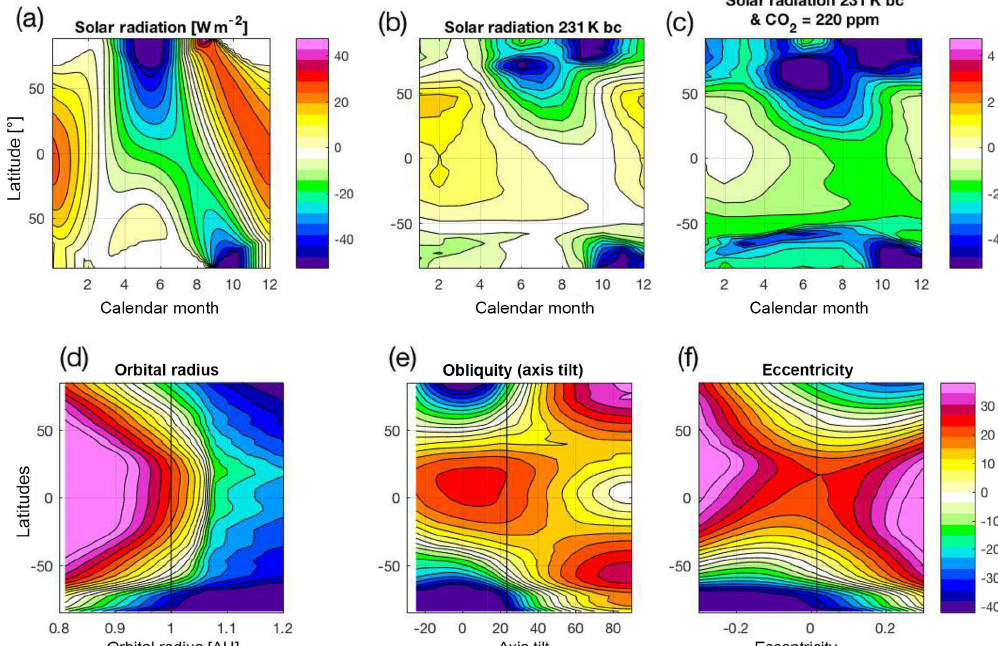
Figure 14. Orbital parameter forcings and T surf responses: (a) incoming solar radiation changes in the solar 231kyr experiment relative to the control GREB model. T surf response in solar 231kyr (b) and solar 231kyr 200ppm (c) relative to the control GREB model. Annual mean T surf in orbit radius (d) , obliquity (e) , and eccentricity (f) . The solid vertical line in (d–f) marks the control (today) GREB